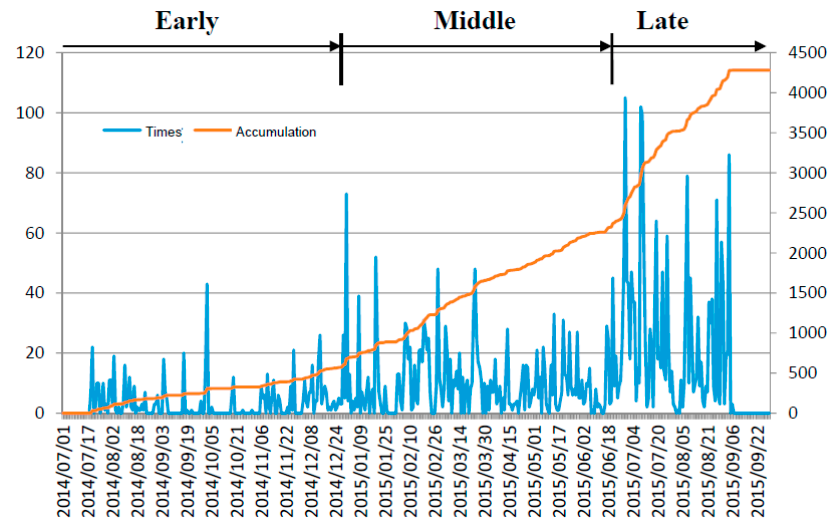
Figure 3. Total use frequency change by actors.